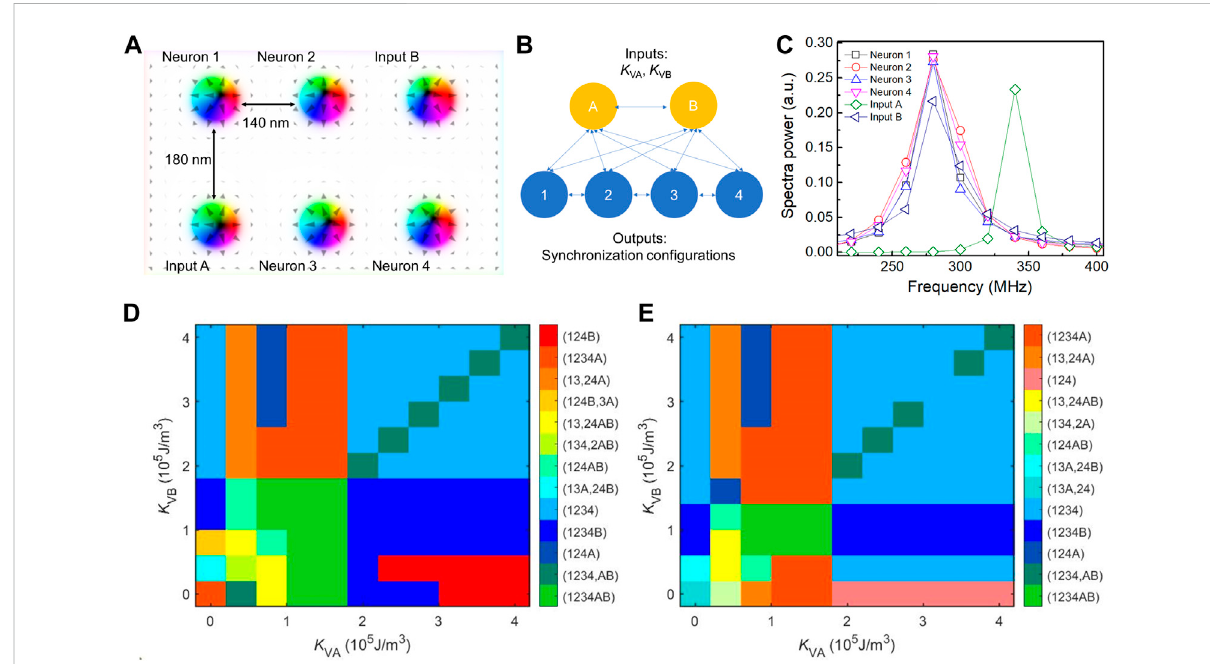
FIGURE 5 (A) Con fi guration of the neural network with two input oscillators (A,B) and four neuron oscillators (1,2,3,4). (B) Schematic illustration for the intercorrelation between the oscillators, neurons, inputs and outputs. (C) The output frequencies of the oscillators, for the case of K VA = 2.4 × 10 5 J/m 3 , K VB = 1.6 × 10 5 J/m 3 . J and for all the oscillators are fi xed at 8 × 10 8 A/m 2 , and K V for neurons 1,2,3,4 are 1.1 × 10 5 J/m 3 , 0.8 × 10 5 J/m 3 , 1.2 × 10 5 J/m 3 , 0.9 × 10 5 J/m 3 , respectively. (D) 2D synchronization map with varying K VA and K VB